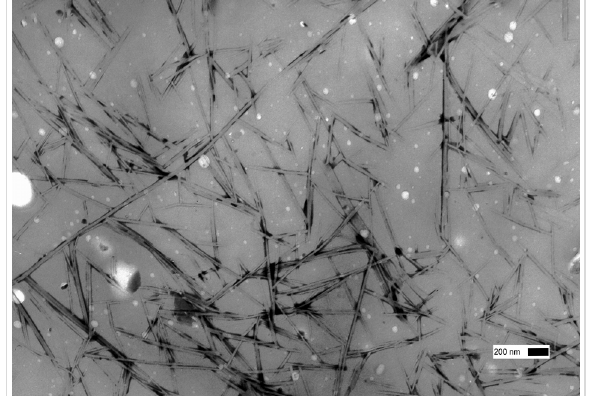
Figure 3: TEM images (PWK staining) of: ( S , R ) -1a H 2 O/DMSO gel.